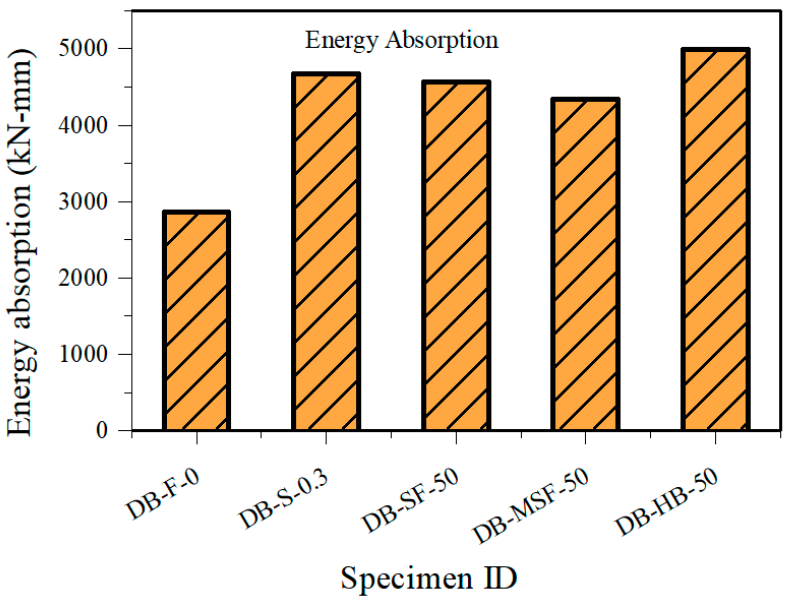
Figure 11. Comparison of energy absorption capacity of all tested deep beams.